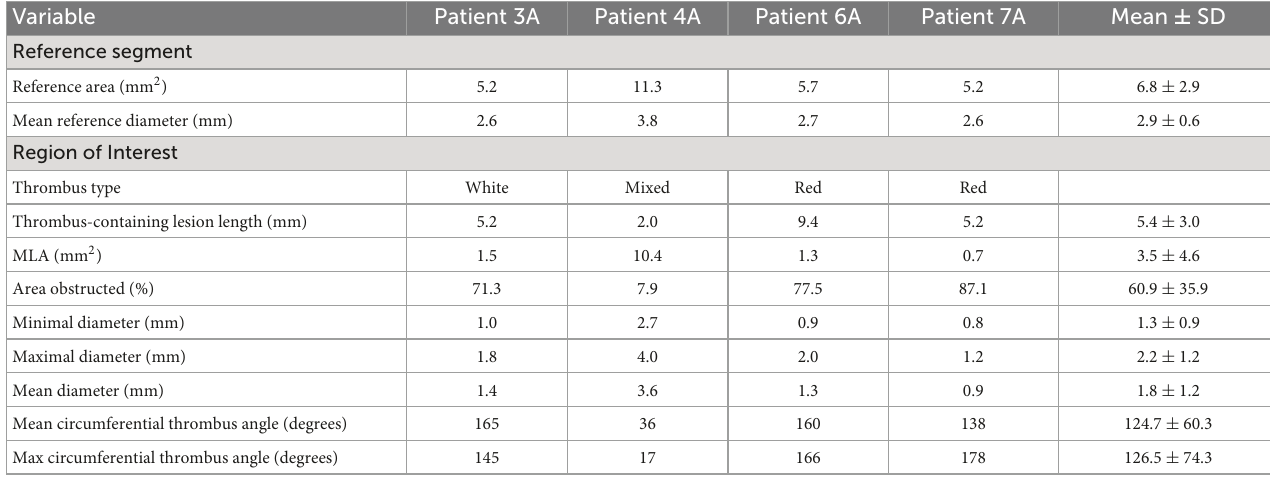
TABLE 1 OCT findings for arteries with thrombus-containing lesions in patients with negative CT scan for pulmonary thrombosis: Cohort A. Variable